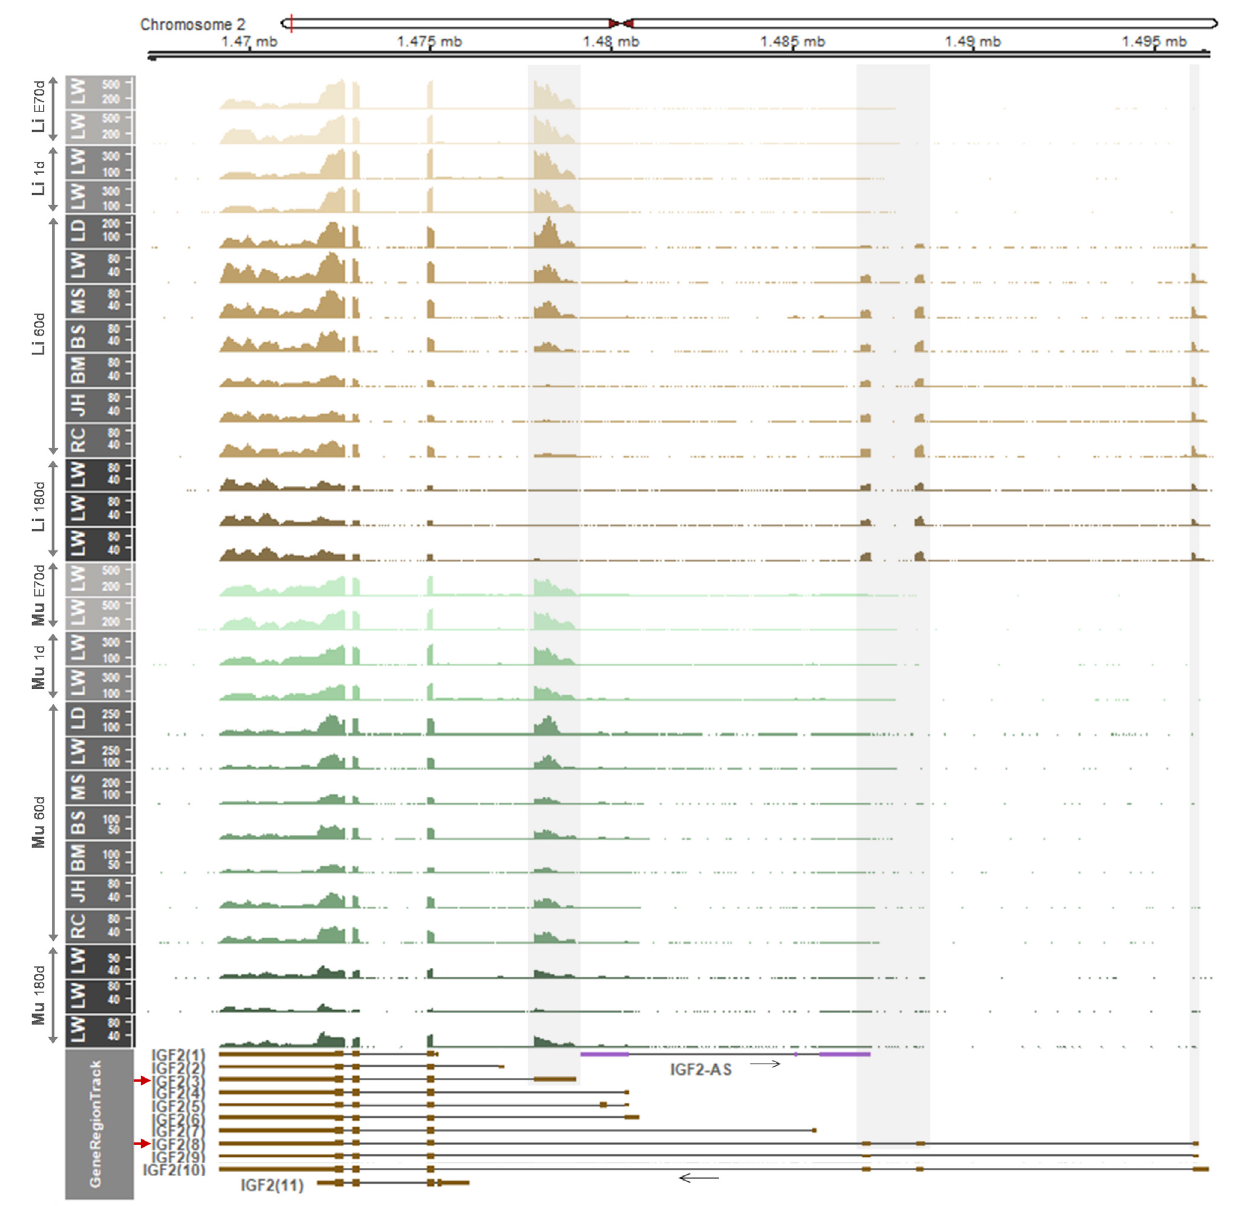
Frontiers in Genetics |